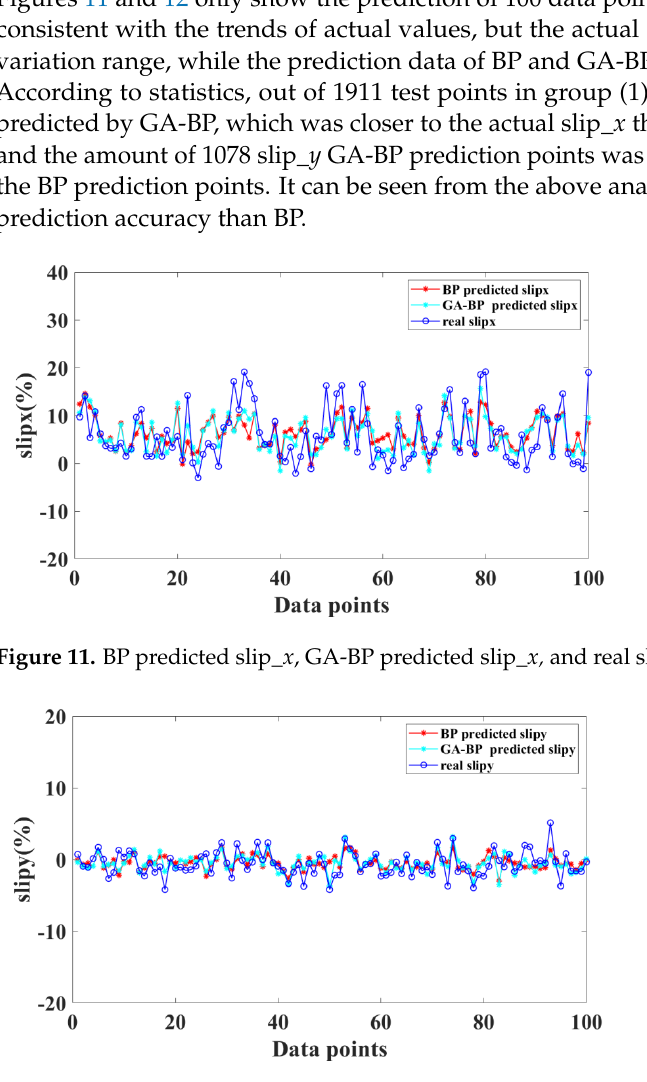
Figure 12. BP predicted slip_ y , GA-BP predicted slip_ y, and real slip_ y (part of the results) .